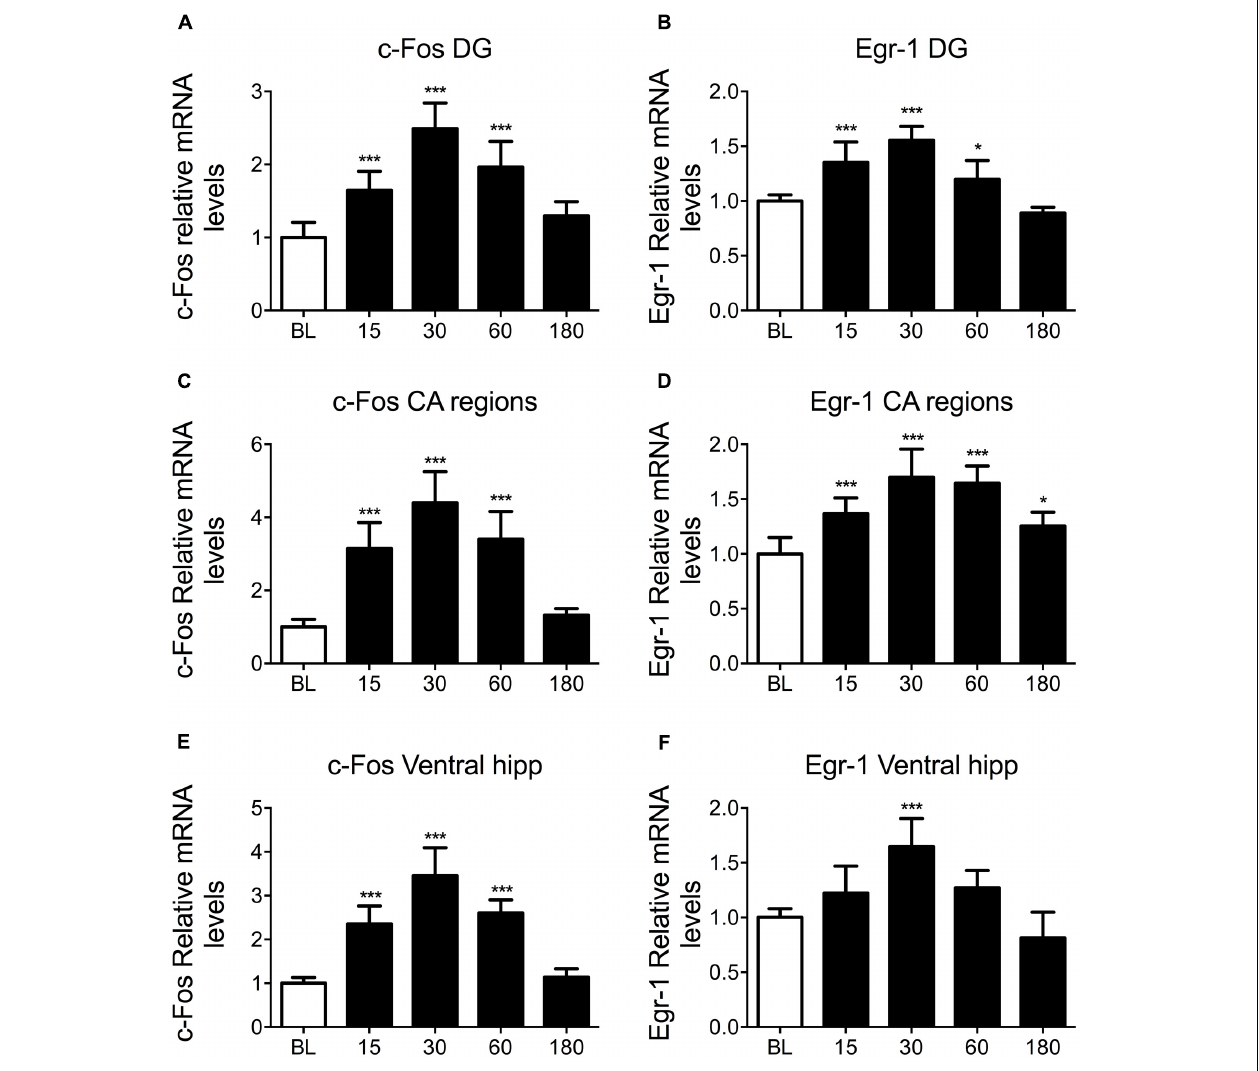
FIGURE 1 | Changes in c-Fos and Egr-1 mRNA in the hippocampus in response to FC. Rats were killed either under baseline conditions, or 15, 30, 60, or 180 min after the start of FC (15 min in 25 ◦ C water). The graphs show mean fold-change over BL mRNA levels (mean ± SEM, n = 7–9) of (A) c-Fos in the DG of the dorsal hippocampus, (B) Egr-1 in the DG of the dorsal hippocampus, (C) c-Fos in the CA regions of the dorsal hippocampus, (D) Egr-1 in the CA regions of the dorsal hippocampus, (E) c-Fos in the ventral hippocampus and (F) Egr-1 in the ventral hippocampus. Relative mRNA expression over housekeeping genes (HPRT1 and YWHAZ) was calculated following qPCR using the Pfaffl method. Statistical analysis: One-way ANOVA; (A) F ( 4 , 38 ) = 36.47, p < 0.0001, (B) F ( 4 , 38 ) = 36.58, p < 0.0001, (C) F ( 4 , 39 ) = 46.87, p < 0.0001, (D) F ( 4 , 38 ) = 22.80, p < 0.0001, (E) F ( 4 , 36 ) = 56.94, p < 0.0001, (F) F ( 4 , 36 ) = 18.77, p < 0.0001. Dunnett’s post